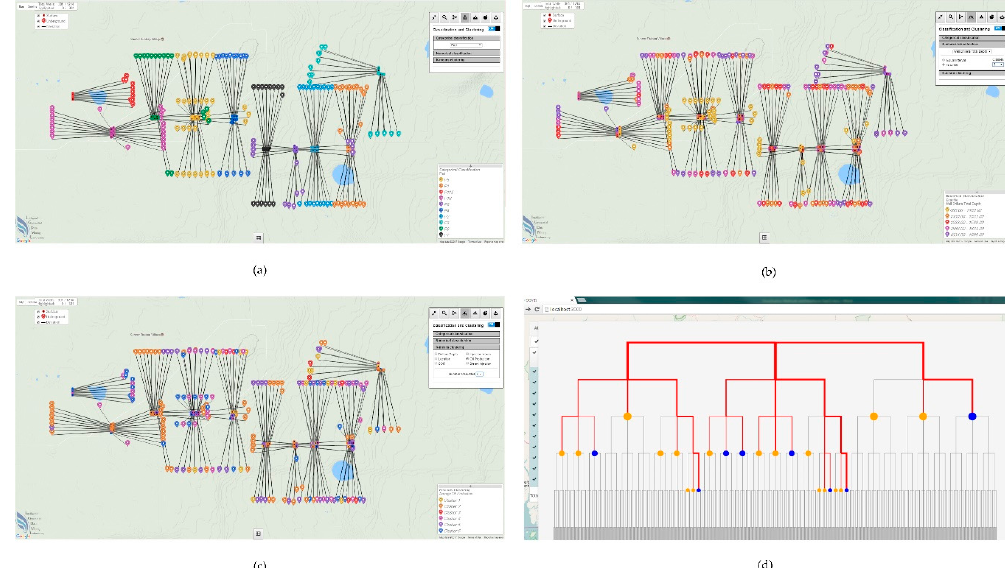
Figure 6. Visualization of data mining results: ( a ) categorical classification of pad; ( b ) quantile classification of production; ( c ) k-means clustering to SOR and oil production; ( d ) hierarchical visualization for symbolic tree production prediction using a symbol size of 3.